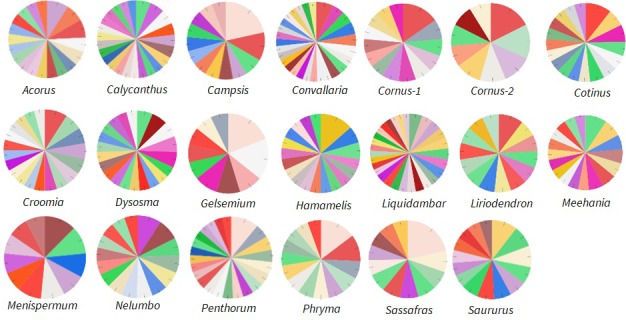
Relative abundance of Ka/Ks > 2 genes annotated to different functions in the Biological Process category; drawn from data in Supplementary file 5.